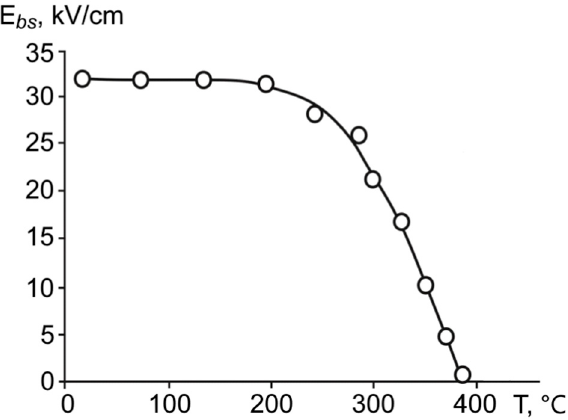
Figure 8. The temperature dependence of internal bias field for ferroelectric BaZrO 3 /BaTiO 3 superlattices.